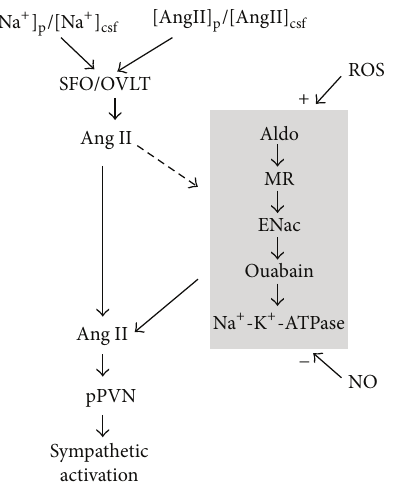
Figure 3: Diagram of the central nervous system pathways that may be activated by an increase in one or more of the following agents: , [ Na + ] , circulating [ Ang II ] and [ Ang II ] . circulating [ Na + ] p csf p csf Left: agents, acting primarily on the sensorial SFO and OVLT, acutely activate a sympathoexcitatory angiotensinergic pathway that increases the activity of the presympathetic pPVN neurons. Right: chronic increase in these agents also activates, via the SFO and the OVLT, a neuromodulatory pathway, which then maintains enhancedexcitatoryangiotensinergicactivityonthepresympathetic pPVN neurons, leading to sustained sympathetic activation and hypertension. See further details in text. Diagram adapted from [10,